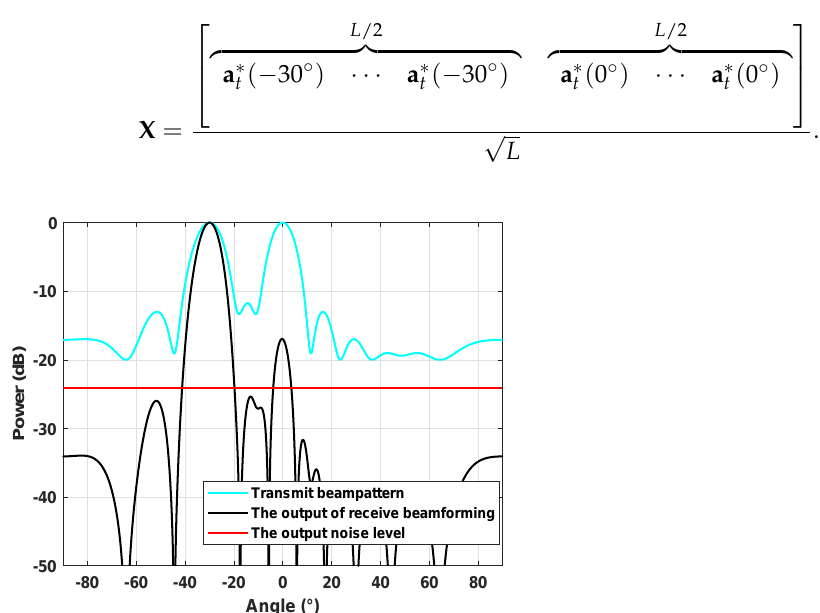
Figure 2. The joint gain of the transmitter and